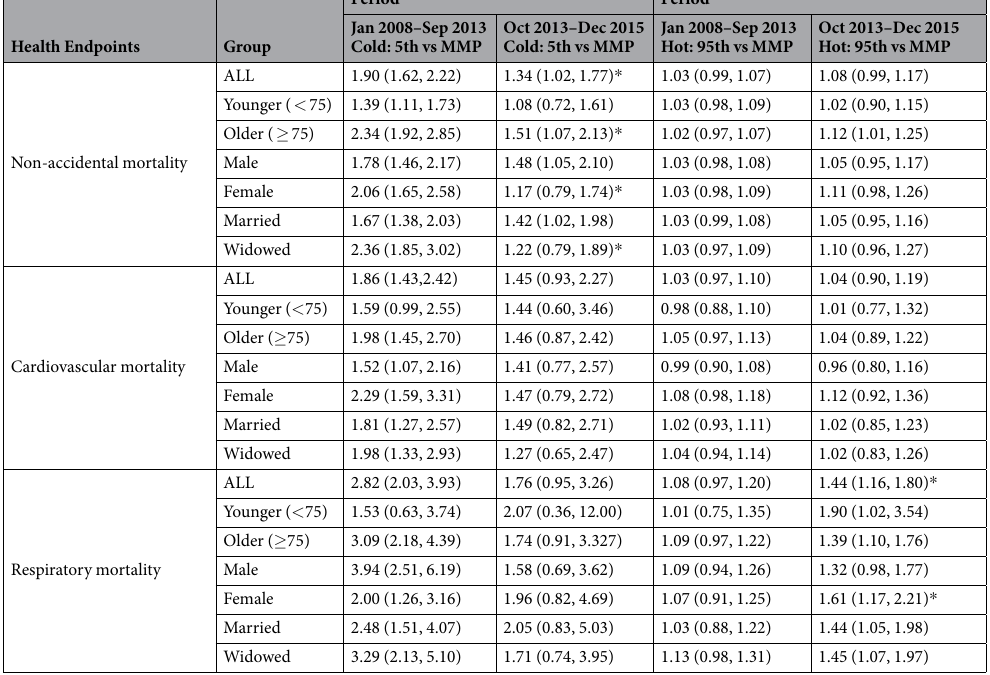
Table 3. The cumulative cold and hot effects on mortality risk due to non-accidental, cardiovascular, and respiratory mortality. MMP: minimum mortality percentile; The MMP for RR of non-accidental, cardiovascular and respiratory mortality were 83, 83 and 79 percentiles, respectively. The 5th and 95th percentiles temperatures were 3.0 °C and 30.4 °C. * P < 0.05 (comparison between two